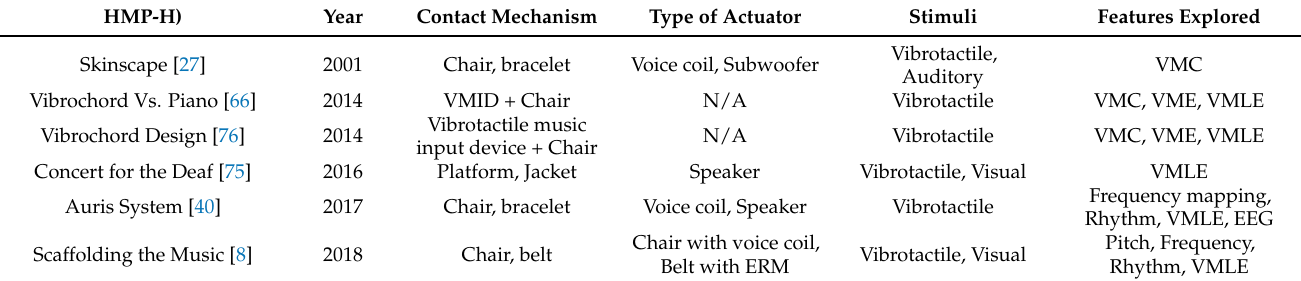
Table 4. Overview of research on haptic music players-hybrid